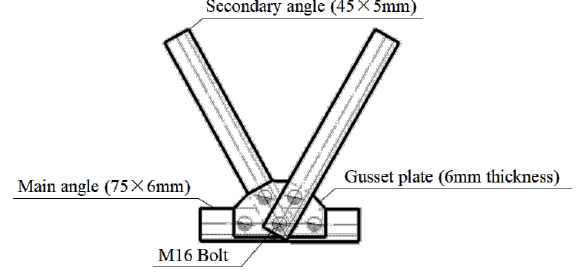
Figure 4: Typical angle joint of transmission tower